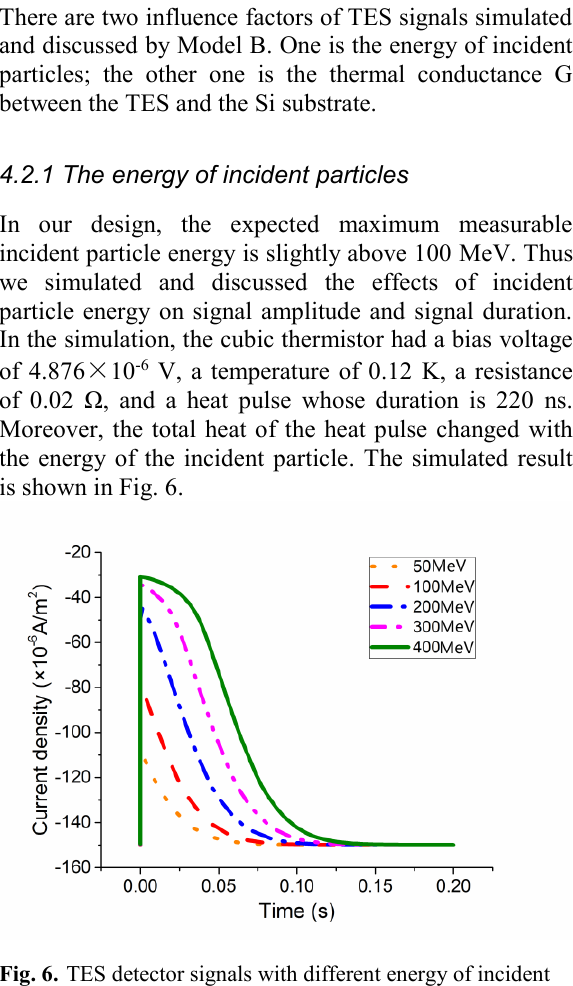
Fig. 6. TES detector signals with different energy of incident particles. As shown, the signals with energy below or close to 100 MeV, is exponentially reduced as expected. However, the signals with energy above 100 MeV, whose peaks are